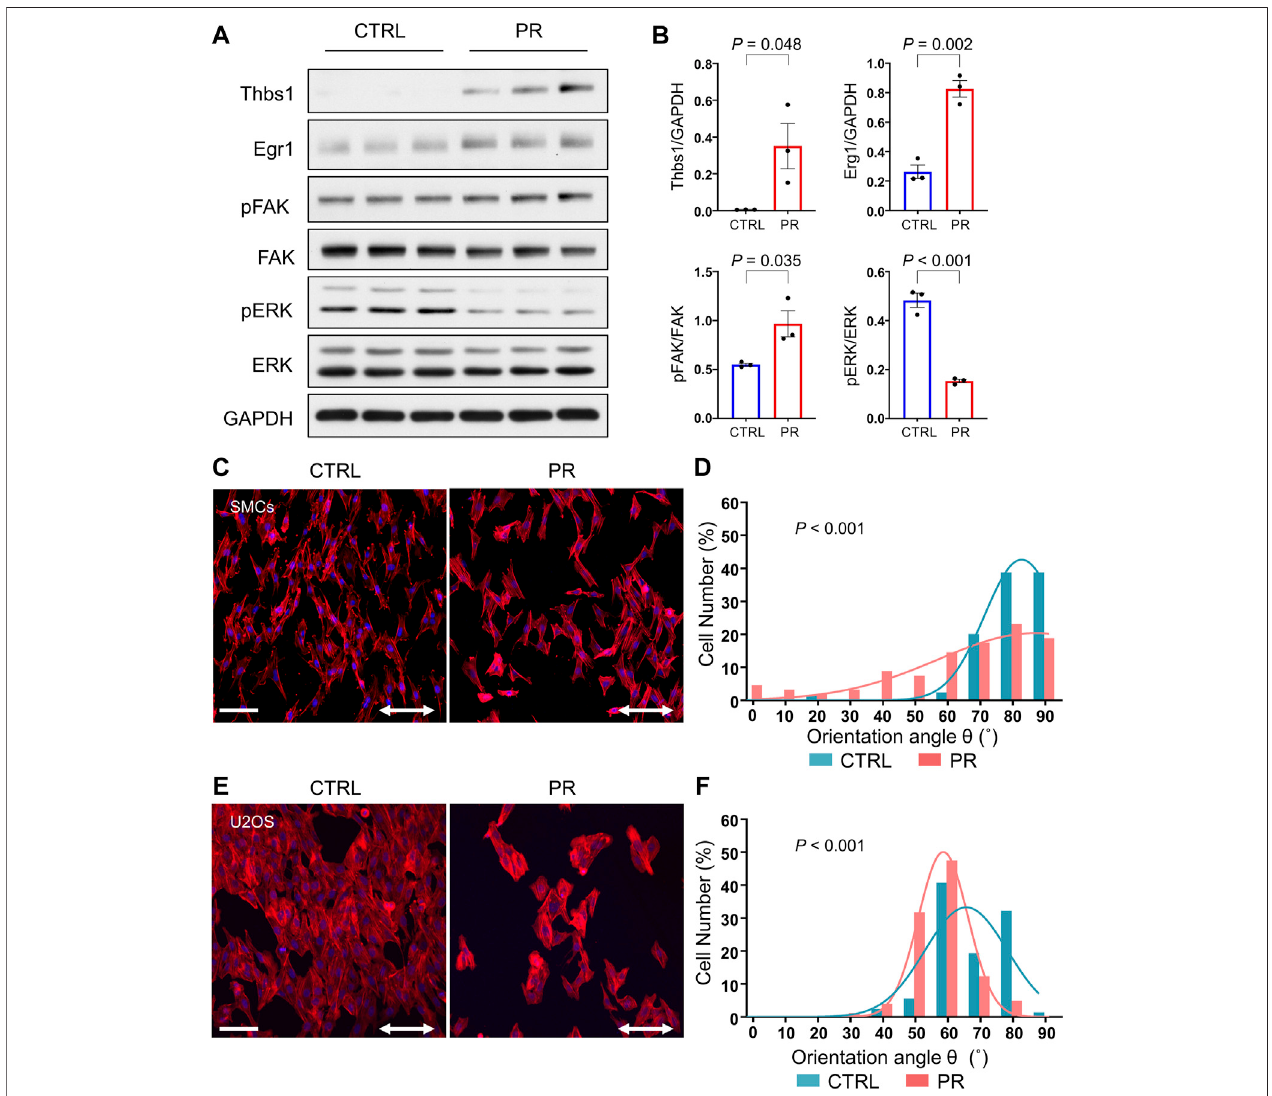
FIGURE 6 | PR 20 prohibits the cyclic stretch-induced reorientation of F-actin stress fi bers. (A) Western blotting shows Thbs1, Egr1, pFAK, FAK, pERK and ERK levels in CTRL and PR 20 -treated (PR) cells ( n = 3). GAPDH was used as a loading control. (B) Quanti fi cation graphs are shown. Bars are means ± SEM. p value shows unpaired t -test. (C,E) RatvascularSMCs(inC)andU2OScells(inE)withorwithout10 µMofPR 20 weresubjectedtocyclicstretch(20%strain,1.0 Hz(60cycles/min)for 6 hours. Phalloidin (red) and DAPI (blue) are shown. Scale bars are 100 µm. The two-way arrows indicate stretch direction. (D,F) Histograms of the percentage of theorientationangle( θ )foreachcellinratvascularSMCs(inD)andU2OScells(inF).Theorientationofeachcellwasanalyzedbymeasuringtheorientationangle( θ )ofthe long axisofthe ellipserelativetothe stretchaxis inCTRL (blue) andPR cells(red). 70to104cells wereevaluated ineach condition. p value showsMann – Whitney Utest.